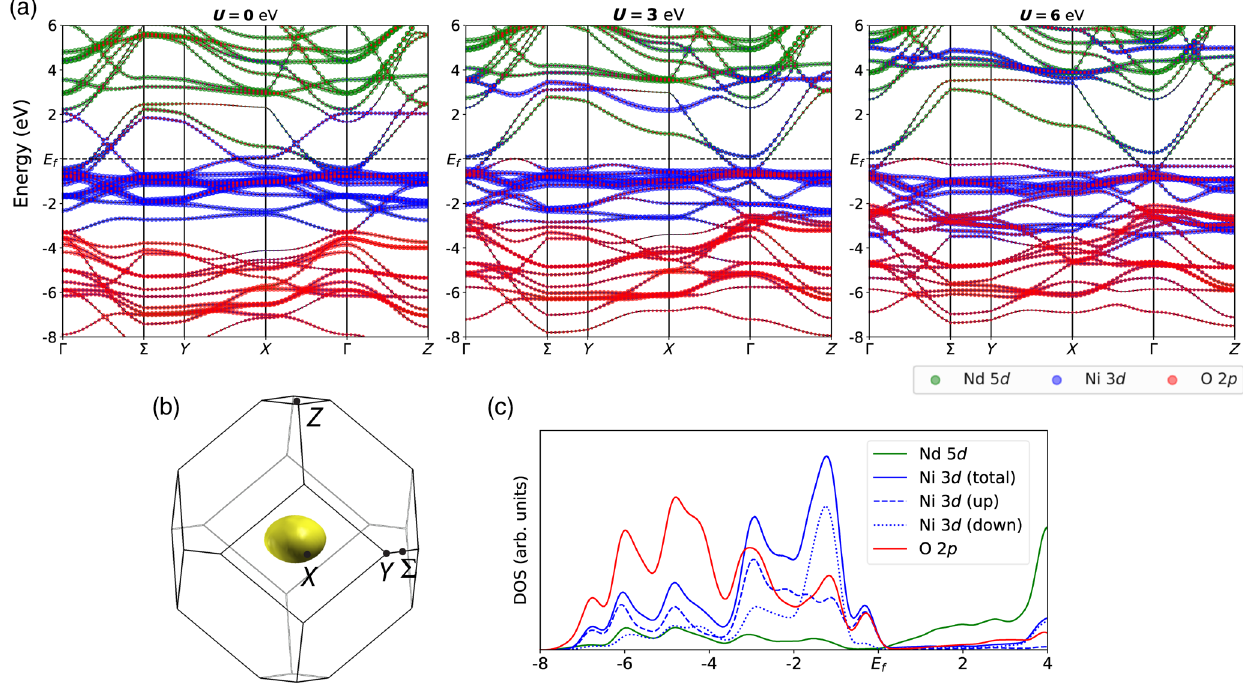
FIG. 2. Electronic structure of NdNiO 2 . (a) GGA and GGA þ U ( U ¼ 3 and 6 eV) calculations of the band structure and the corresponding atomic orbital character of NdNiO 2 . The “ lower Hubbard band ” and “ upper Hubbard band ” splitting in DFT þ U scenarios are apparent; specifically, for U ¼ 6 eV, they are located at about − 0 . 5 – 0 eV and 3.5 – 5 eV relative to E f , respectively. (b) Visualization of Fermi surface geometry in the first BCT BZ for NdNiO 2 in the GGA þ U (6 eV) calculation. (c) Partial density of states of NdNiO 2 in GGA þ U (6 eV) calculation — included are contributions from spin-polarized Ni 3 d states on one Ni atom to elucidate the symmetry in the two-Ni cell. In summary, the orbital character of the bands at the Fermi surface is dominated by Nd 5 d , forming the electron pocket at the zone center. It is notable that this electron pocket becomes somewhat smaller but does not disappear with a larger value of U . In contrast, the nickel 3 d bands just below the Fermi energy hardly change with different U